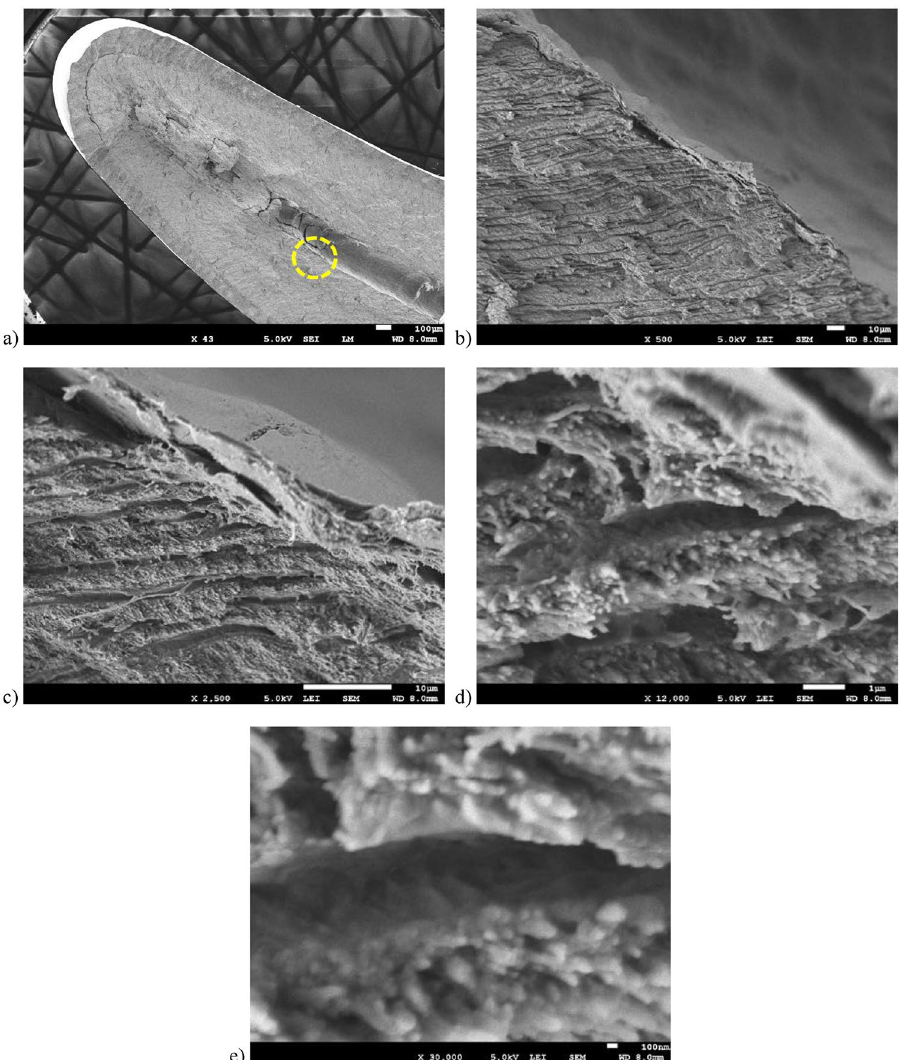
Figure 2. SEM micrographs of a SiS ZnO treated tooth sample with increasing magnification. ( a ) Image taken at 43 X magnification with dashed circle highlighting region of interest. Scale bar is 100 μ m. Images ( b – e ) are all centered on the same spot. ( b ) SEM micrograph at 500 X magnification. Scale bar is 10 μ m. ( c ) SEM micrograph at 2.5 KX magnification. Scale bar is 10 μ m. ( d ) SEM micrograph at 12 KX magnification. Scale bar is 1 μ m. ( e ) SEM micrograph at 30 KX magnification. Scale bar is 100